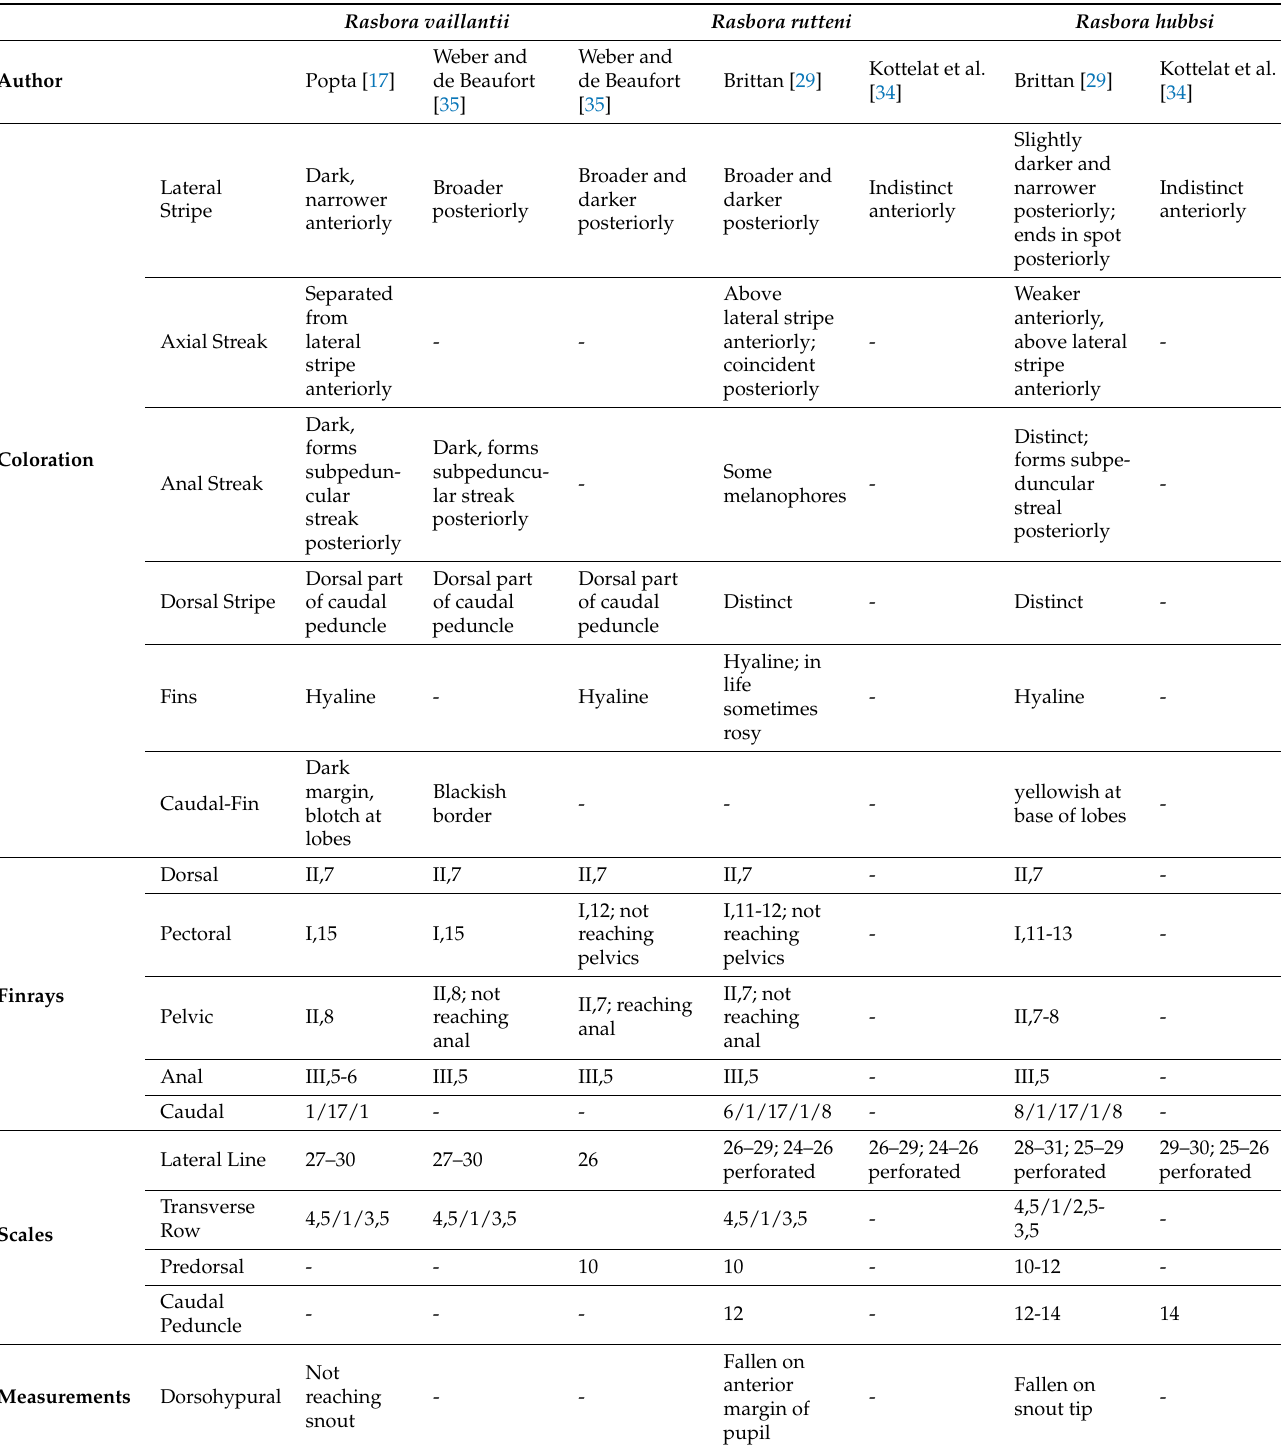
Table 2. Most-relevant characters considered for the identification of Rasbora cf. hubbsi , R . rutteni , and R . vaillantii . “-” indicates missing data in the quoted